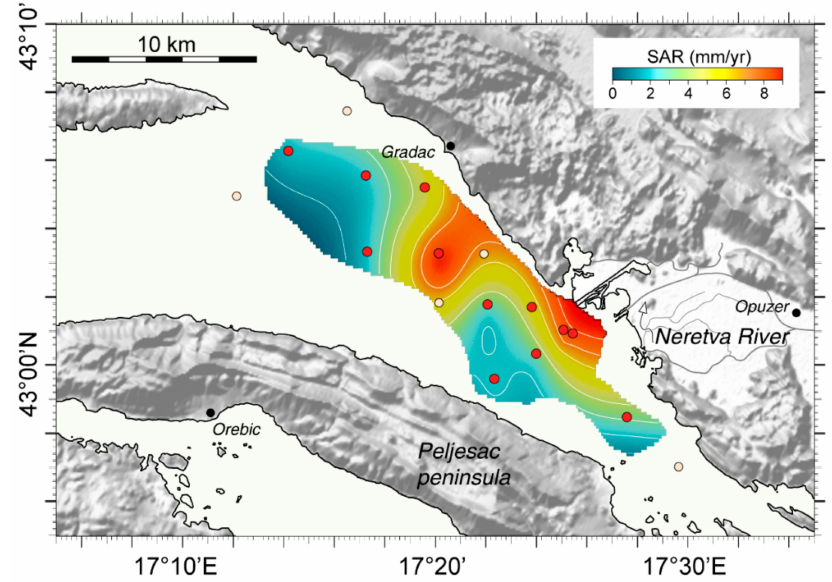
Figure 6. Apparent sediment accumulation rates (SAR) over the study